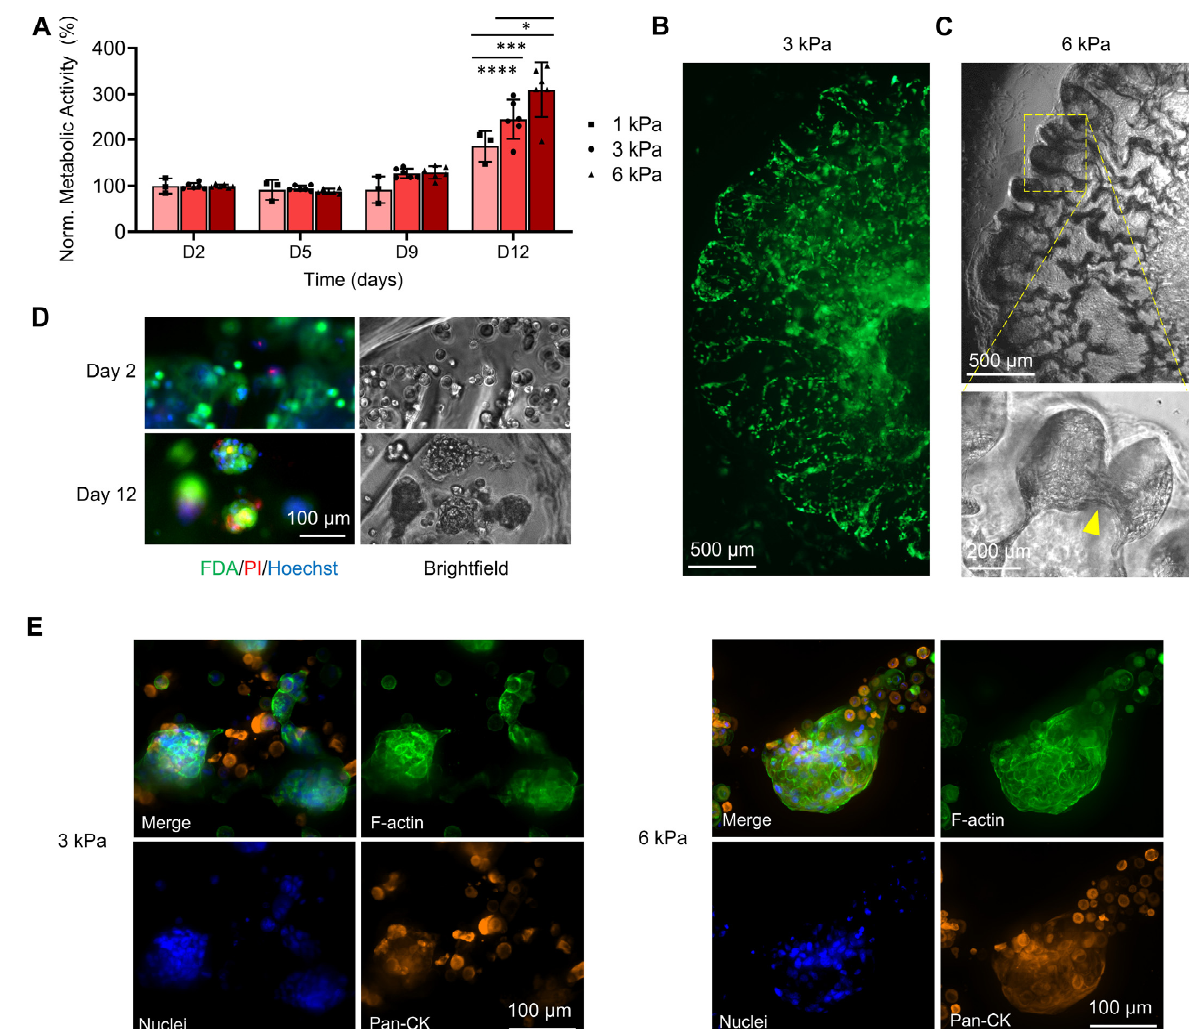
Figure 5. Effect of GelSH gel stiffness on the growth and viability of breast cancer patient-derived organoids (BCa PDOs) up to 12 days of culture (P#04F): ( A ) Metabolic activity of BCa PDOs over time, normalized to 1 kPa, Day 2. Means ± SD shown, n = 3–6 technical replicates (* p < 0.01, *** p < 0.001, **** p < 0.0001). ( B ) FDA staining of 3 kPa GelSH after 12 days of culture. ( C ) Brightfield images of cells in 6 kPa GelSH after 12 days of culture forming bridging organoids (yellow arrows). ( D ) Epifluorescence images of FDA/PI/Hoechst staining in 3 kPa GelSH and corresponding brightfield microscopy images, showing live cells (green), dead cells (red), cell nuclei (blue), and overall morphology, respectively, after 2 and 12 days of culture. ( E ) Confocal fluorescence images of immunofluorescence for cell nuclei (blue), cytokeratin (Pan-CK, orange), F-actin (green) after 12 days of culture.